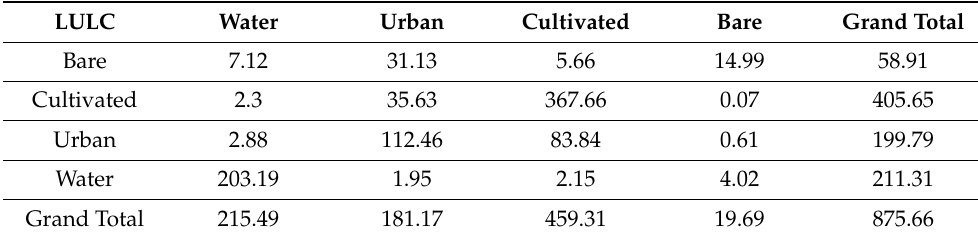
Table 9. Transition of LU/LC (km 2 ) from